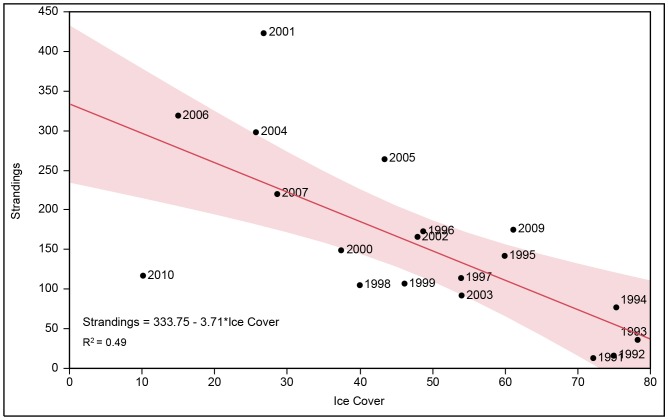
The relationship between percent sea ice cover and yearly harp seal strandings.The graph represents a linear regression between percent ice cover in February in the Gulf of St. Lawerence and yearly strandings along the Northeastern United States. The shaded area shows 95% confidence intervals.